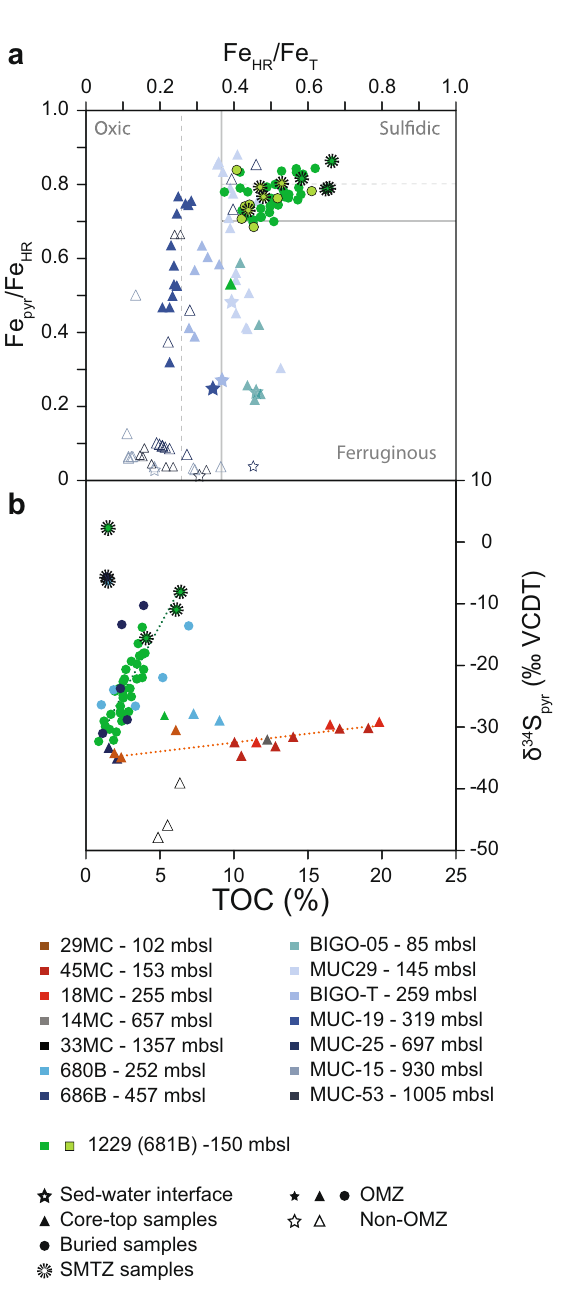
Fig. 3 Fe speciation-TOC- δ 34 S pyr systematics. a Cross plot of the ratio of pyrite Fe to highly reactive Fe (Fe pyr /Fe HR ) against highly reactive Fe to total Fe (Fe HR /Fe T ) in sediment − water interface (0 – 1 cmbsf; stars), core- top 28,44 (<50 cmbsf; triangles) and buried 28,44 (>50 cmbsf; circles) samples. Horizontal and vertical lines indicate the proposed boundaries for distinguishing euxinic from ferruginous and oxic water columns 43,69 , where solid lines are at Fe pyr /Fe HR and Fe HR /Fe T recommended on the basis of modern environments, and dashed lines are suggested boundaries for ancient sediments. b δ 34 S pyr vs. TOC for core-top 51 and buried (this study) samples. Dotted lines represent the trendlines observed between Intra- OMZ core-top and SWI δ 34 S pyr values and TOC (orange) and down-core δ 34 S pyr values and TOC (green). Samples located within the upper SMTZ are outlined in dotted black. Filled symbols represent cores located within the OMZ, whereas open symbols represent cores outside the